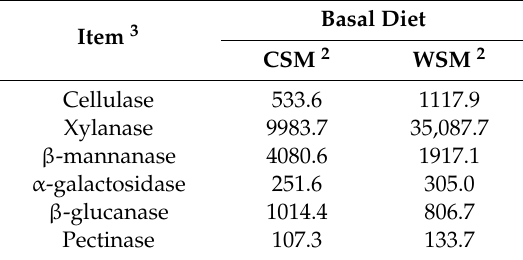
Table 3. The exogenous enzymes composition of optimal carbohydrase mixtures for corresponding basal diets 1 , U / kg of dry matter